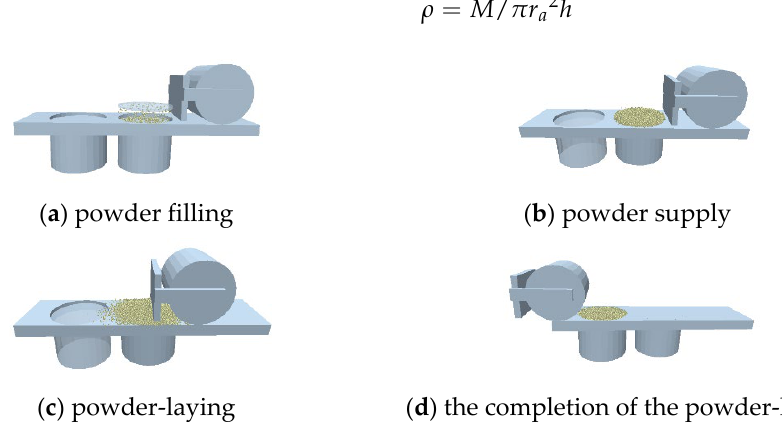
Figure 7. Simulates the motion process of the powder laying.